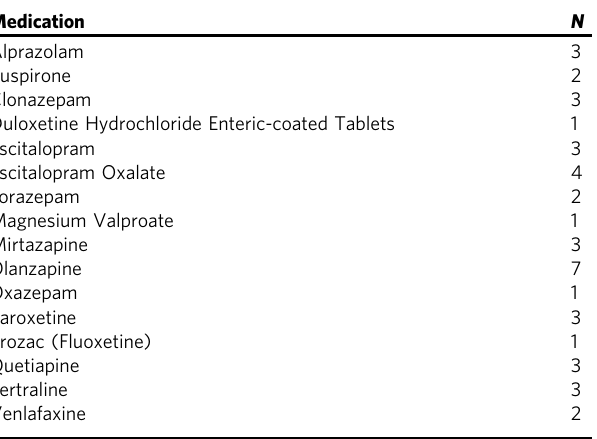
This table summarizes the medications taken by the MDD patients.